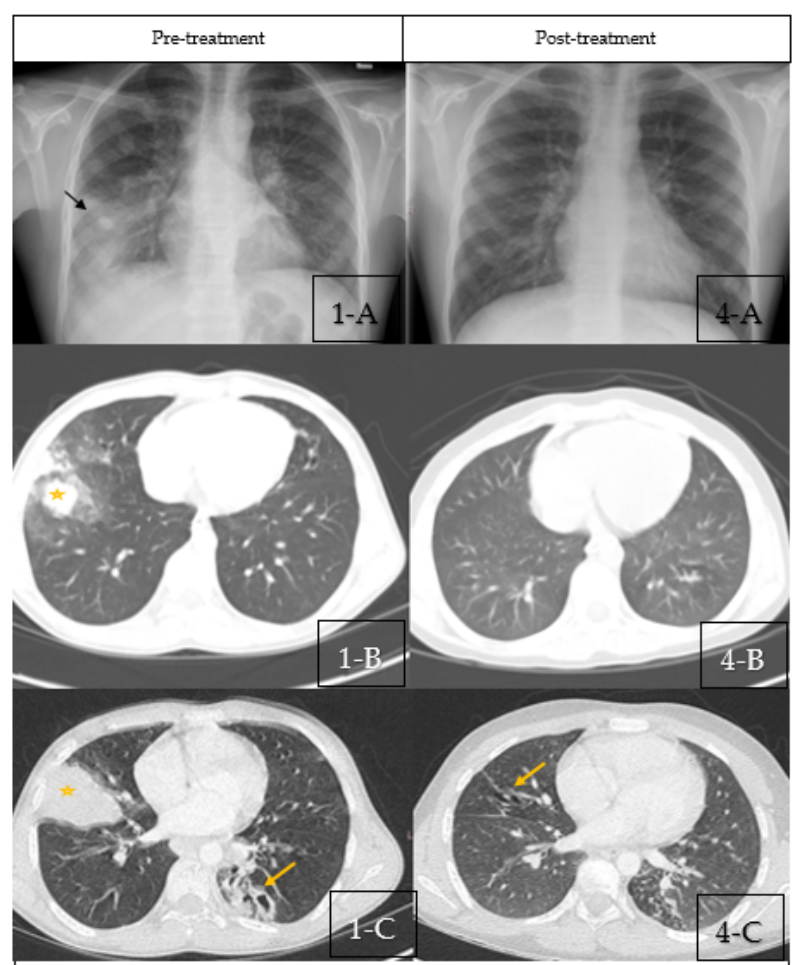
Figure 1. Figures ( 1-A – 1-C ) Pre-treatment Imaging. Figure ( 1-A ): Chest X-ray pre-treatment with pulse steroids showing right middle lobe con-solidation (Black Arrow) with bilateral scattered nodular opacities. Figures ( 1-B , 1-C ): Coronal sections of chest CT scan at diagnosis showing bilateral central bronchiectasis, mucus impaction (Yellow Arrow) and areas of segmental, and subsegmental atelectasis (Star). Figures ( 4-A – 4-C ) Post-treatment Imaging: Figure ( 4-A ): Chest X-ray post-treatment with pulse steroids showing disappearance of right middle lobe consolidation. Figures ( 4-B , 4-C ): Coronal sections of chest CT scan post-treatment with pulse steroids showing resolution of the previous findings with residual bronchiectasis (Yellow arrows).